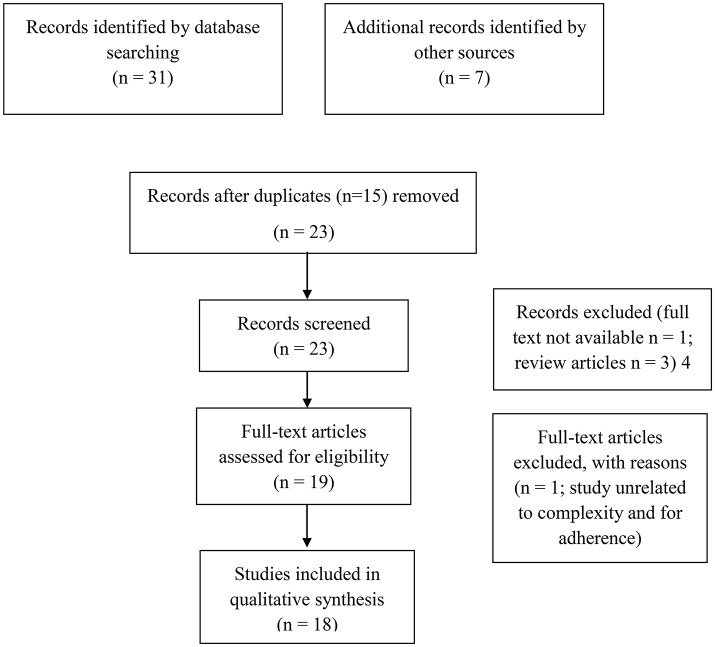
PRISMA flow diagram.